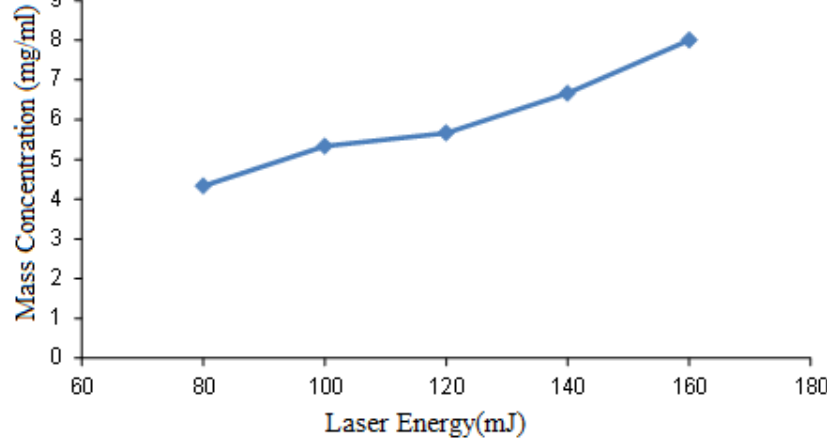
Figure 2: Mass concentration of ablated TiO 2 NPs versus laser energy.